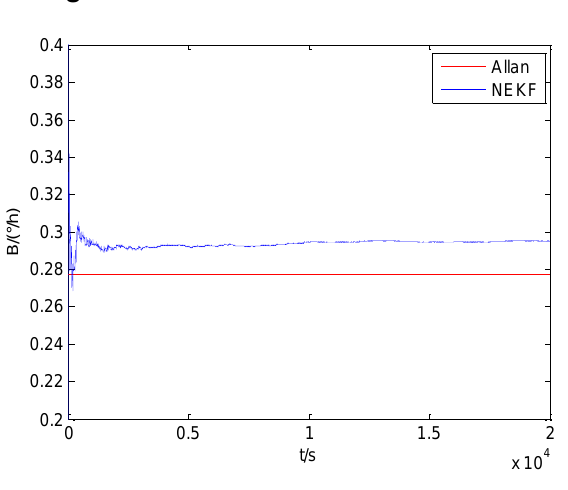
Figure 25. Estimation of B for #1